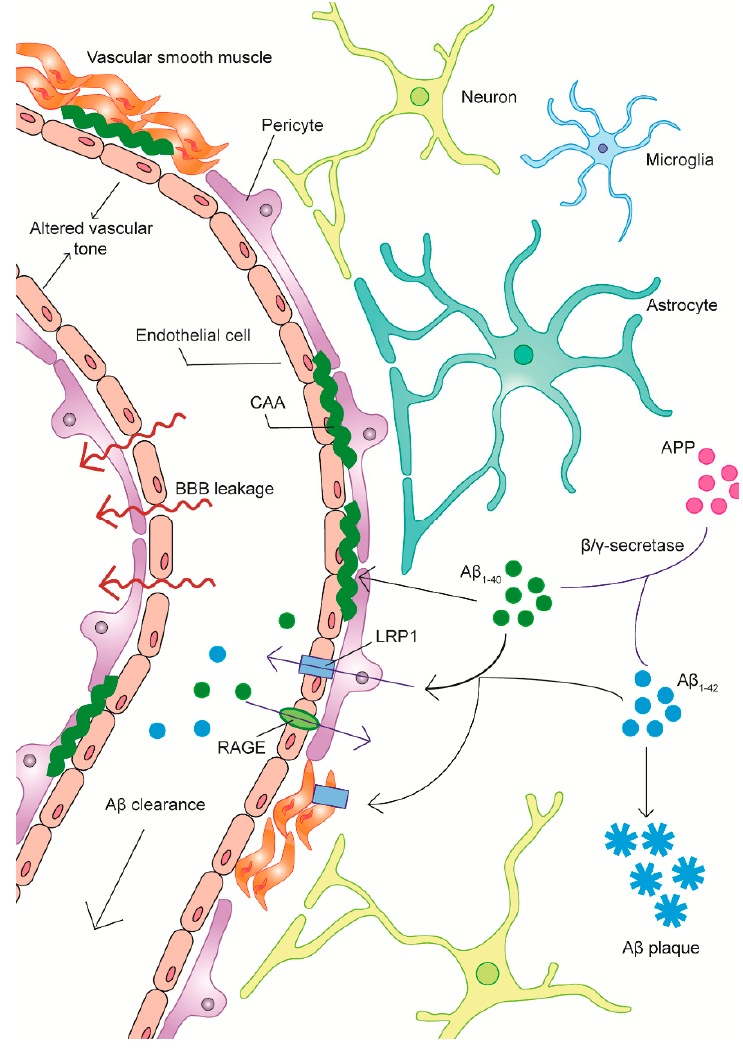
Figure 1. Dysregulated Amyloid- β (A β ) Clearance in Alzheimer’s Disease (AD). The vasculature is the site of a complex amyloid- β clearance system. Pathological A β species, including A β 1-40 and A β 1-